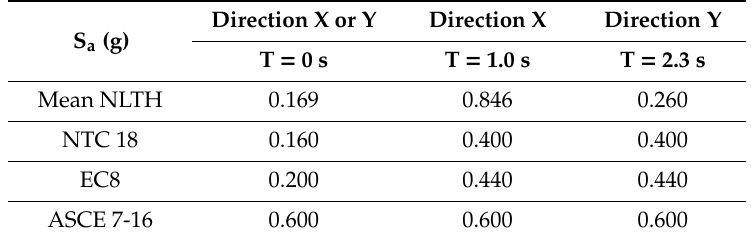
Table 6. Spectral absolute acceleration values for RP = 140 years for three periods of interest.